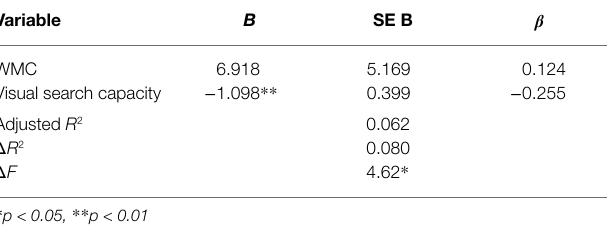
TABLE 5 | Summary of the standard multiple regression for resumption lag following 15-s interruptions.